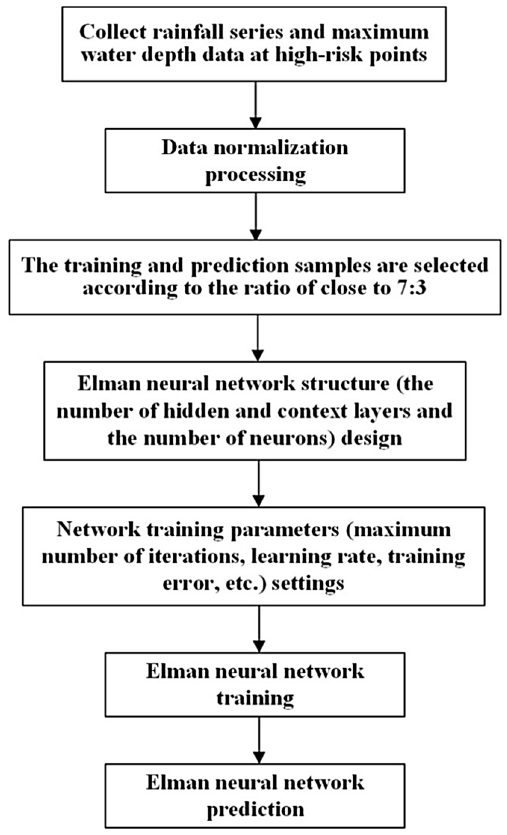
Fig. 3 A framework for the rapid prediction of urban stagnant water based on the Elman neural network